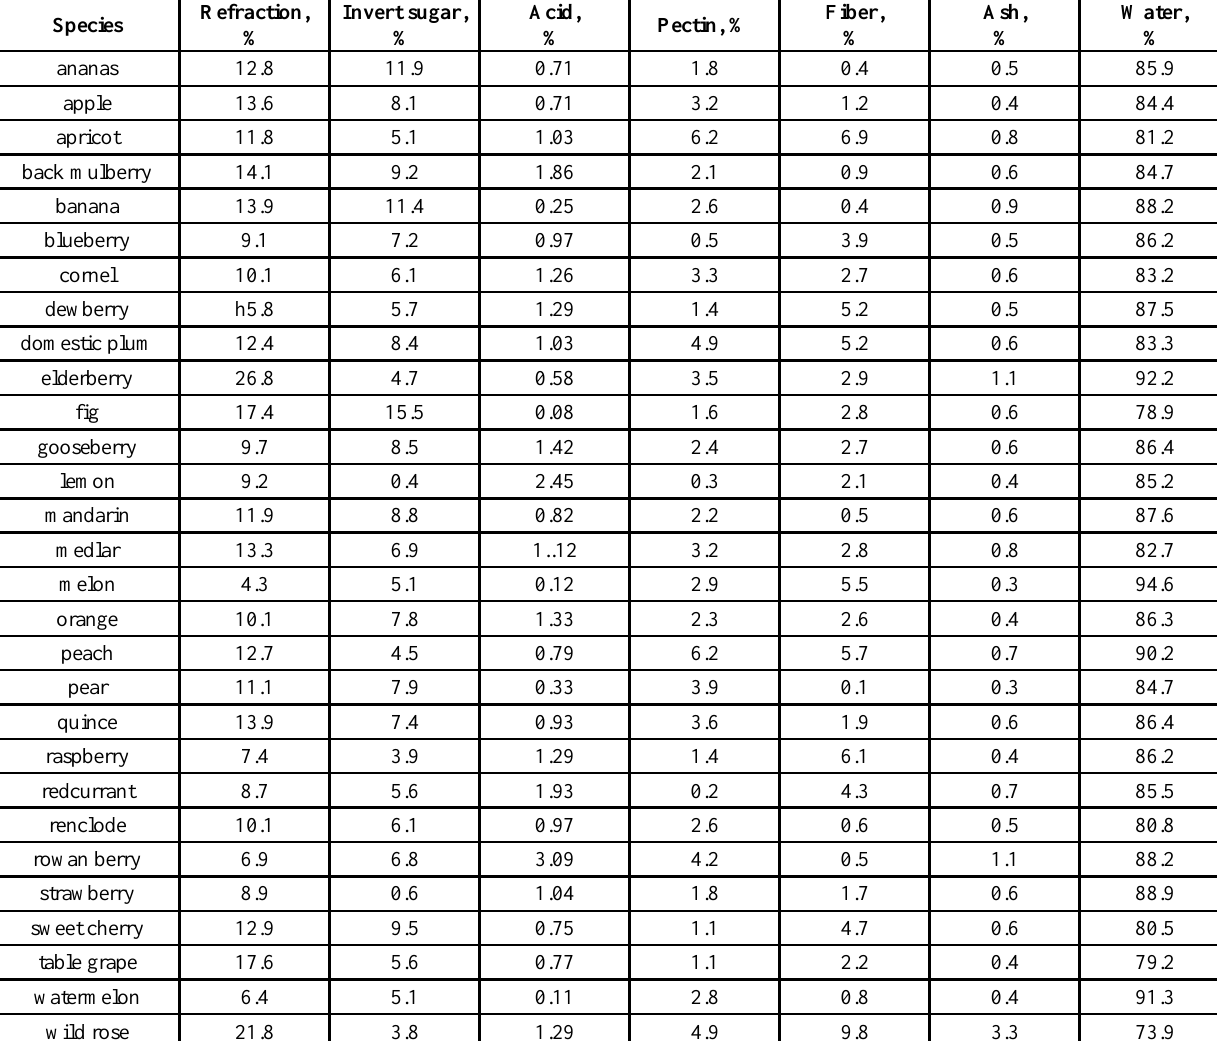
Table 1. Nutritional values of fruit species (HÉRICS – TÓTH 1926,